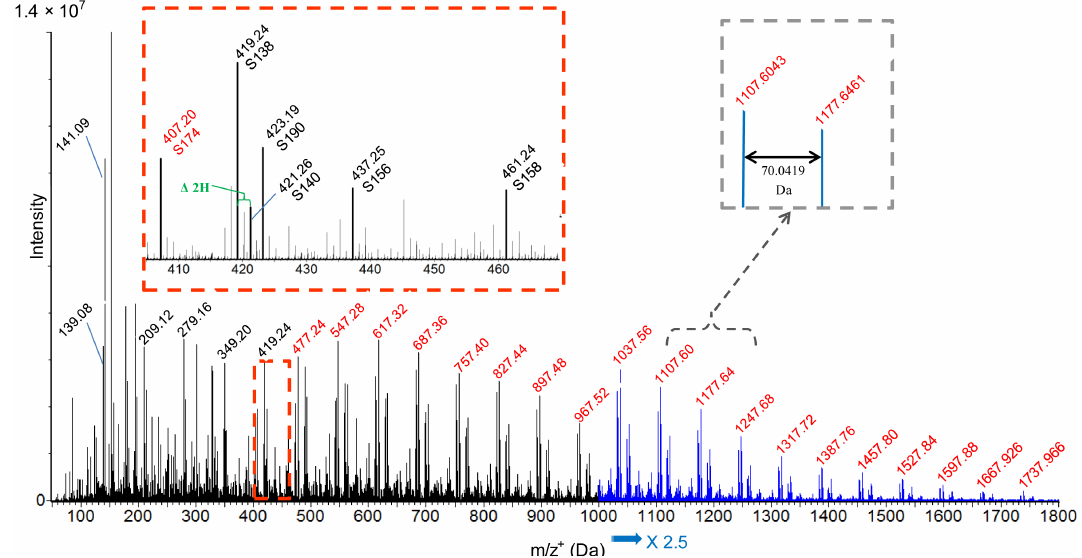
Fig. 1. Mass spectrum (obtained using UPLC-ESI-MS from 0 to 1800Da) for the retention time range 0 to 7min, in the positive mode, at t = 50 min of experiment C. The most intense series (S174) is highlighted in red. Each group of peaks represents a degree of polymerization (DP). Left zoom: main series detected for DP = 4. Right zoom: MVK regular pattern of mass differences of 70.0419Da. Another regular pattern of mass difference of 2.0157Da corresponding to 2H is also observed (in green in the left